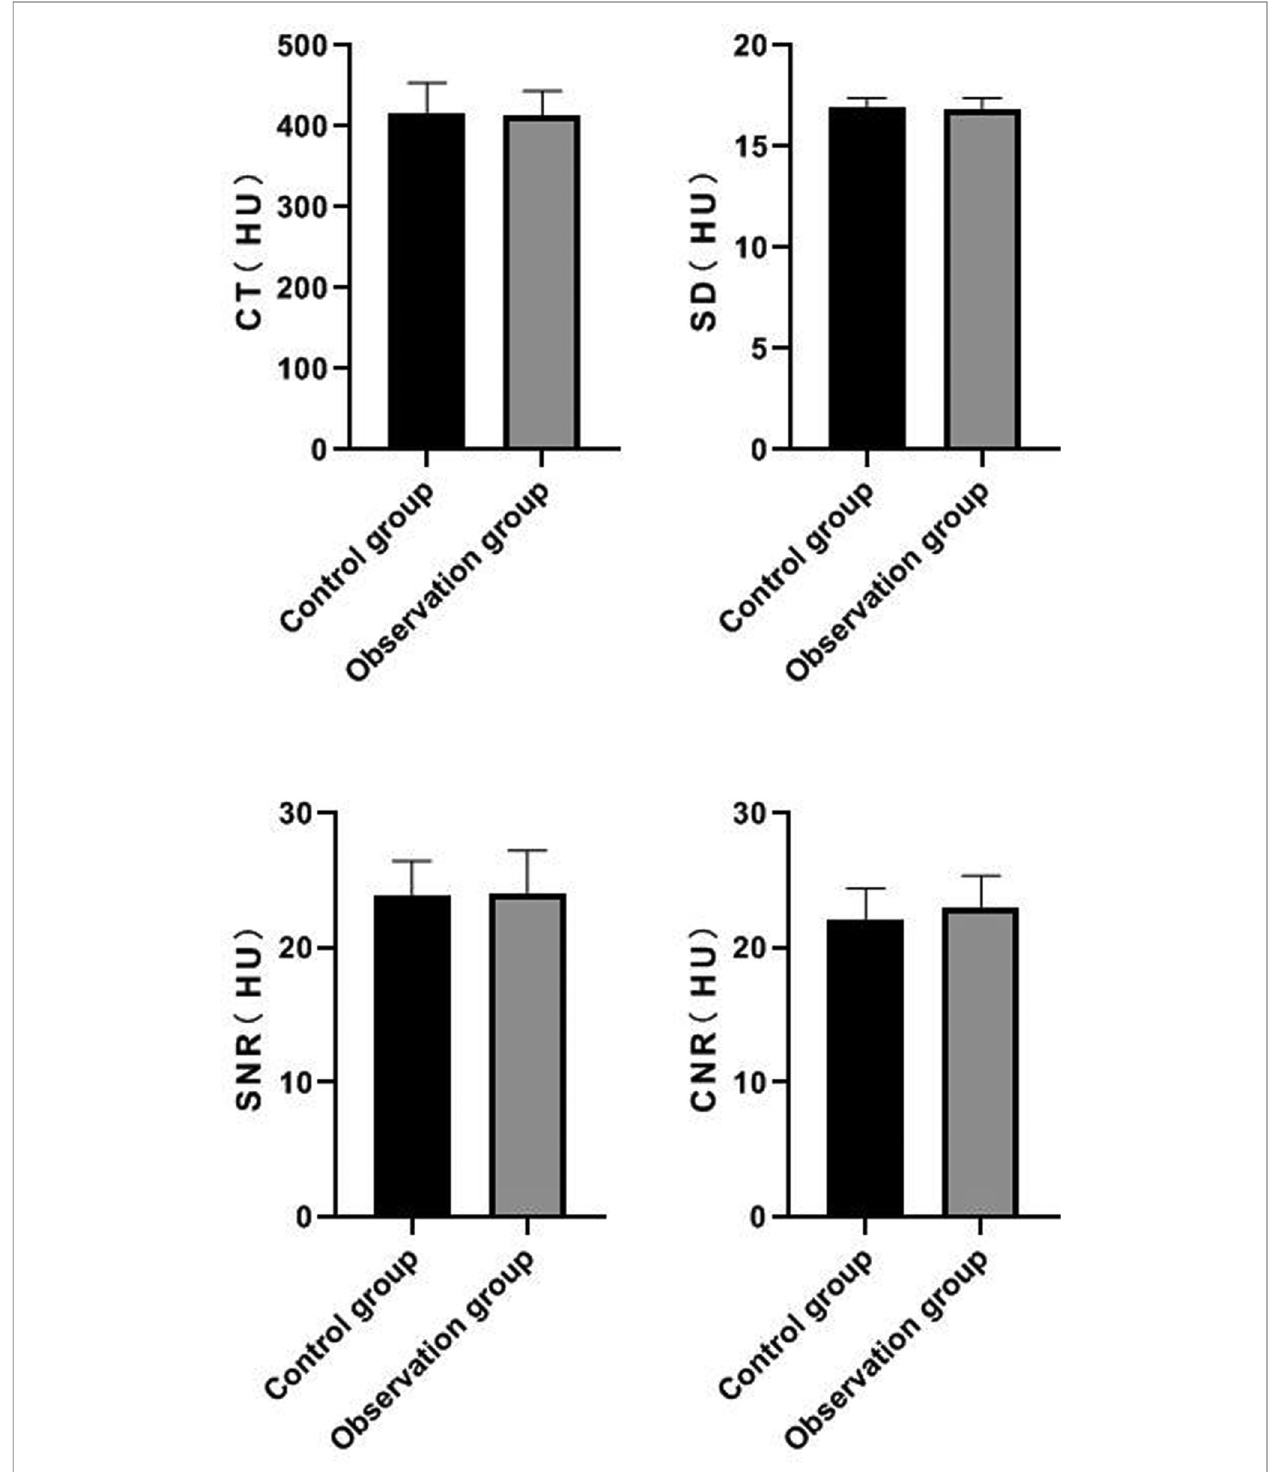
FIGURE 2 | Comparison of measured values of femoral artery segment between the two